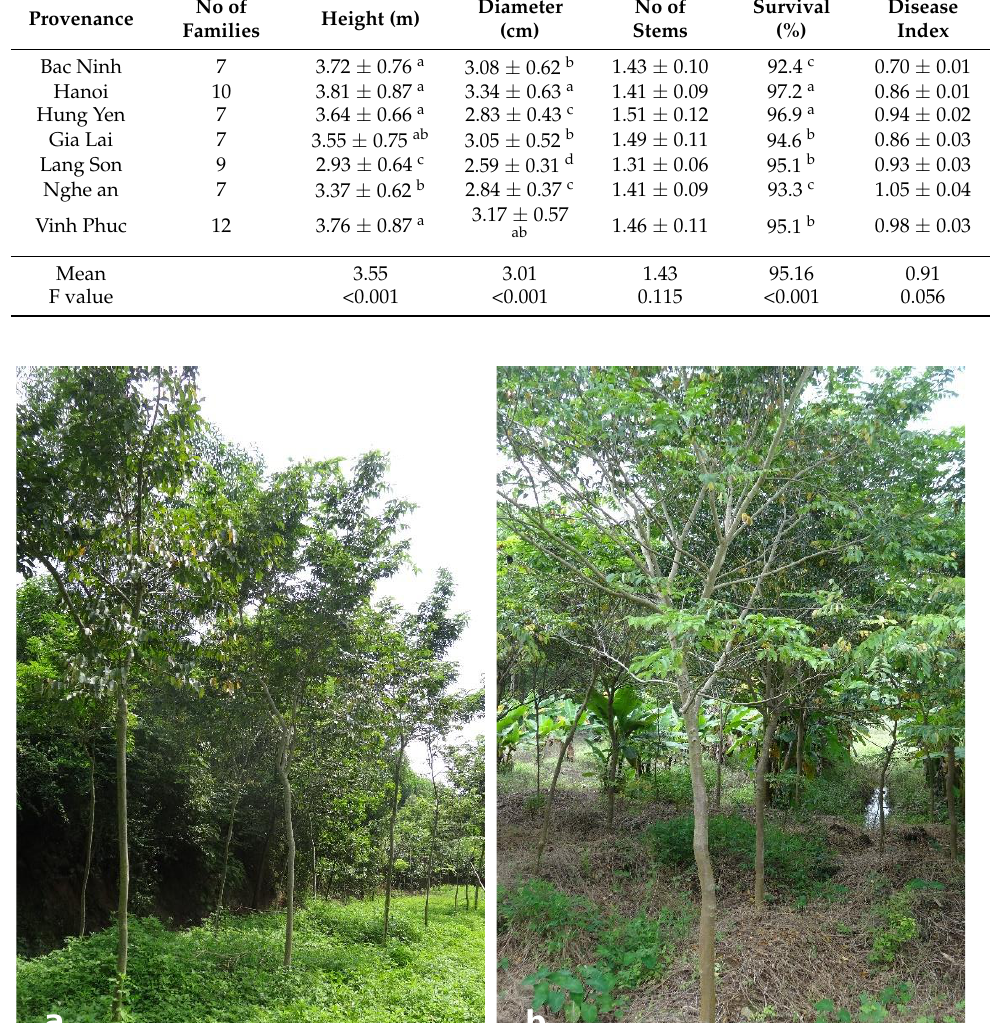
Table 3. Trial means, individual heritability, and coefficients of additive genetic variation for the studied traits of D. tonkinensis provenances.